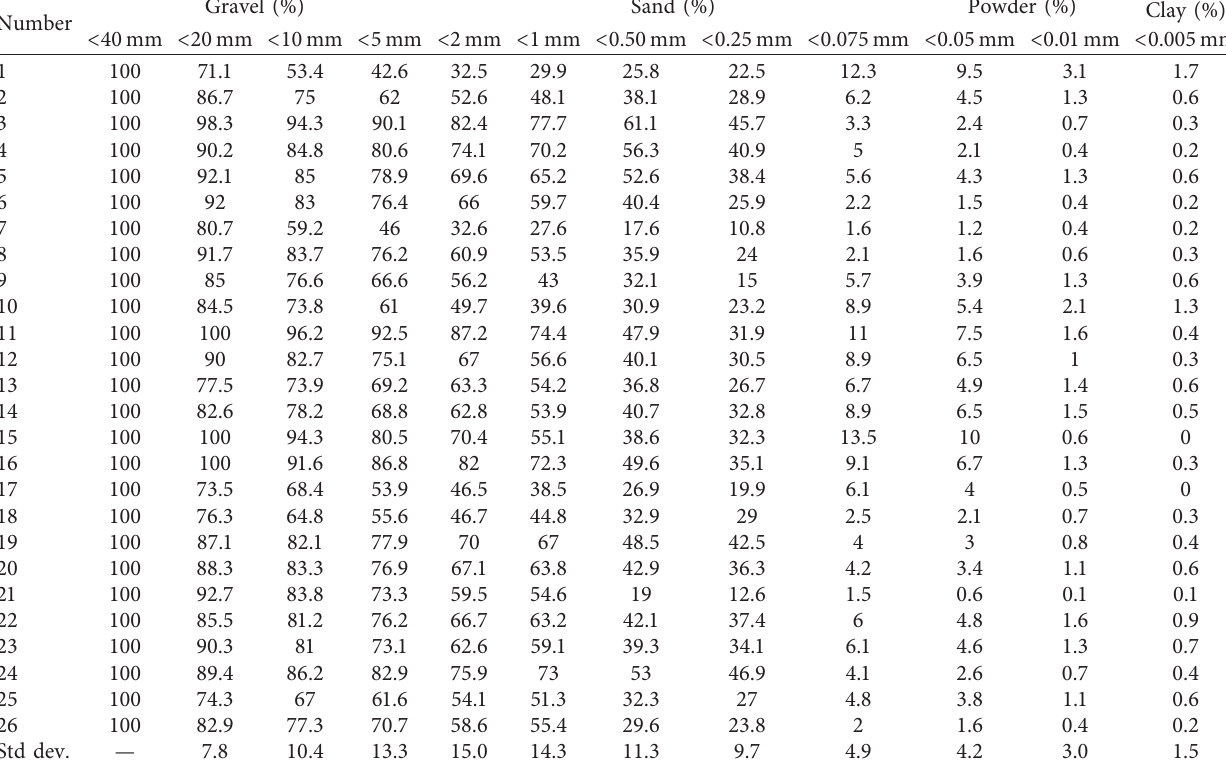
Table 1: Glacier debris flow gradation